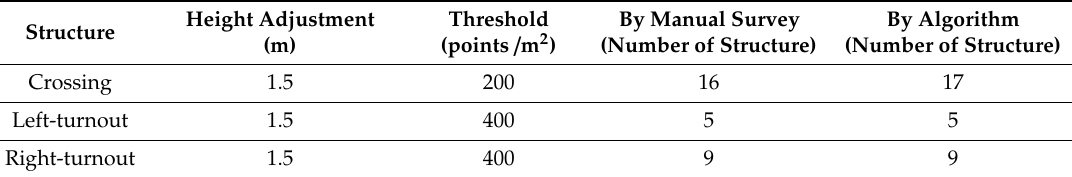
Table 4. Structure detection results—Railway line